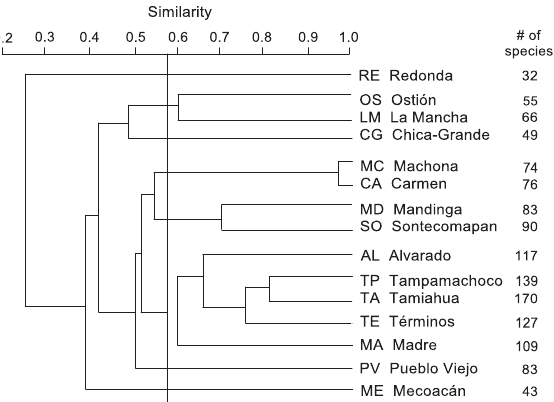
Fig. 4. Cluster of Mexican lagoons of the Gulf of Mexico based on fish species; vertical line (0.57) indicates the level of group recognition